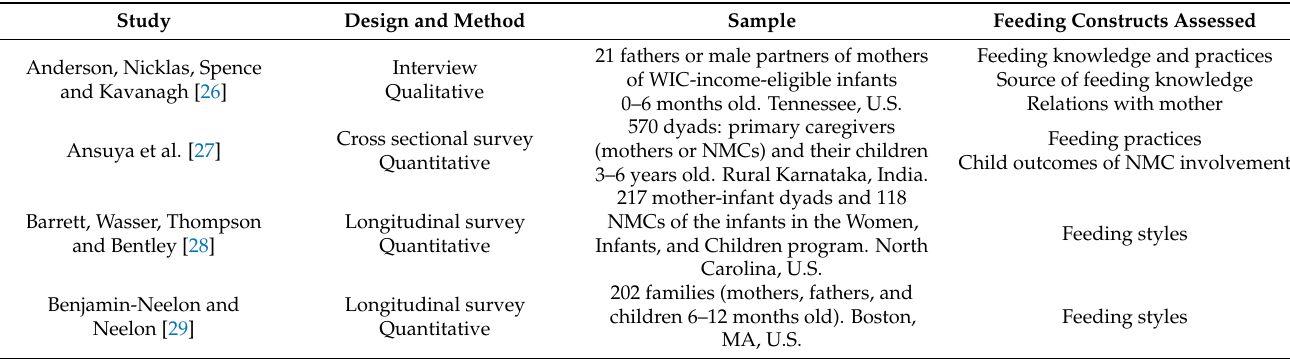
Table 1. Summary of characteristics of studies in the review.